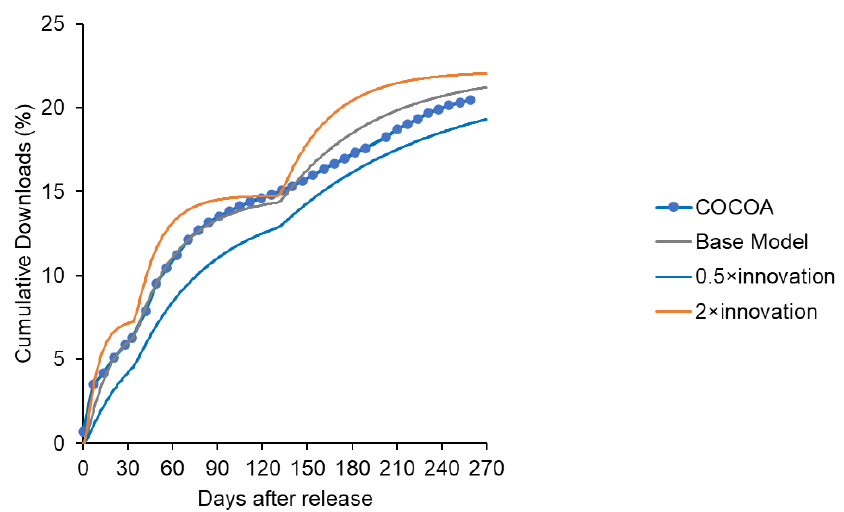
Figure 9. Representation of the change in the number of downloads of COCOA expressed by a system dynamics model with a layered structure.